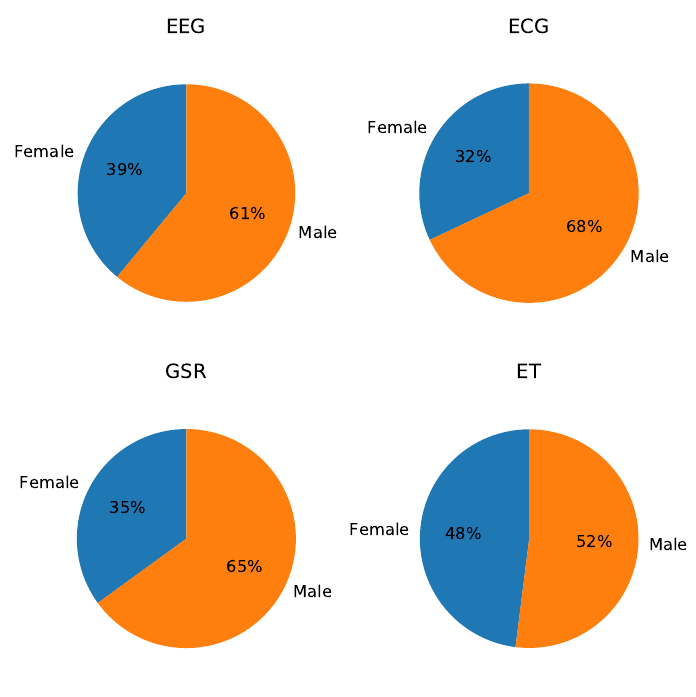
Figure 4. Subject sex ratio in experiments by